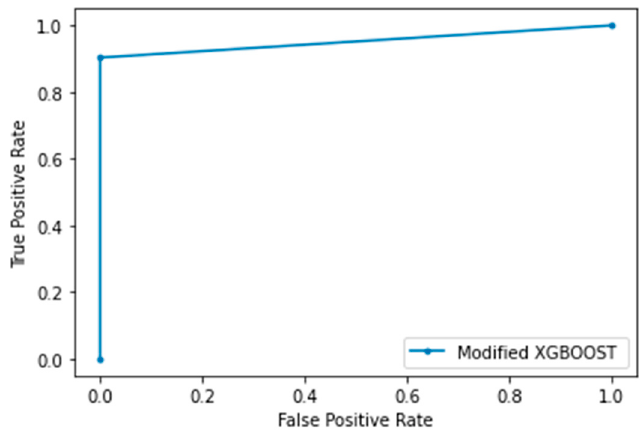
Figure 13. ROC curve.